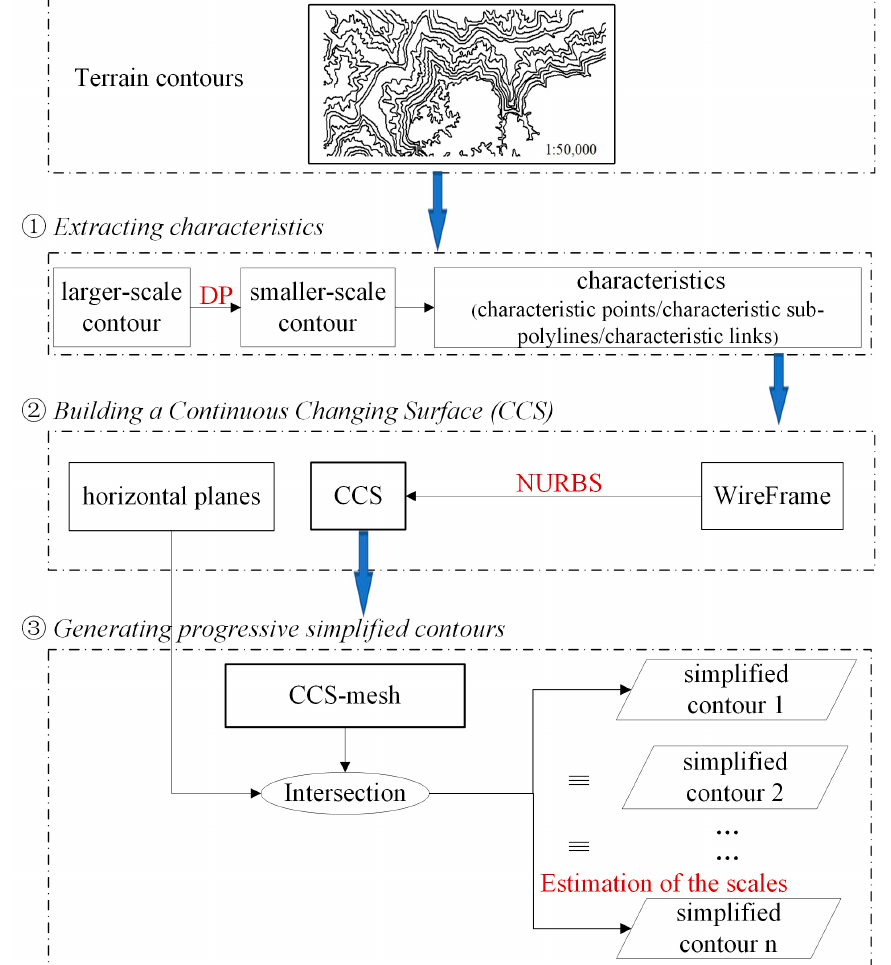
Figure 1. CCSM methodological framework.